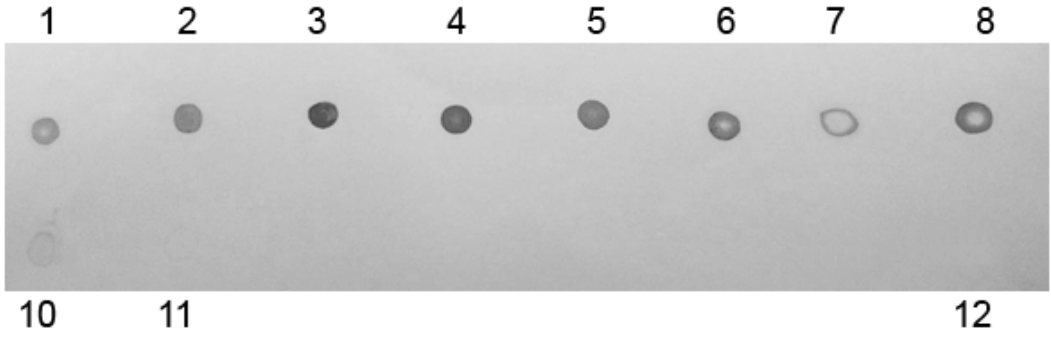
Figure 4. Dot-immunoblotting analyses of recombinant bovine lactoferrin (rbLf) from induced clones. Following 72 h of induction, proteins were harvested from supernatant and were spotted in a polyvinylidene difluoride (PVDF) membrane. Lanes 1–8: protein samples of each clone; Lane 10: commercial bovine lactoferrin (bLf) (0.5 mg/mL); Lane 11: commercial bLf (0.05 mg/mL); Lane 12: protein extracts from native P. pastoris .